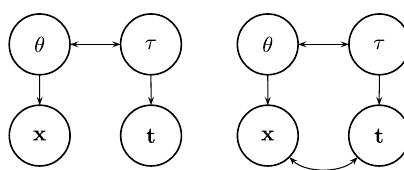
Fig. 1 Measurement Models: M1 (left) and M2